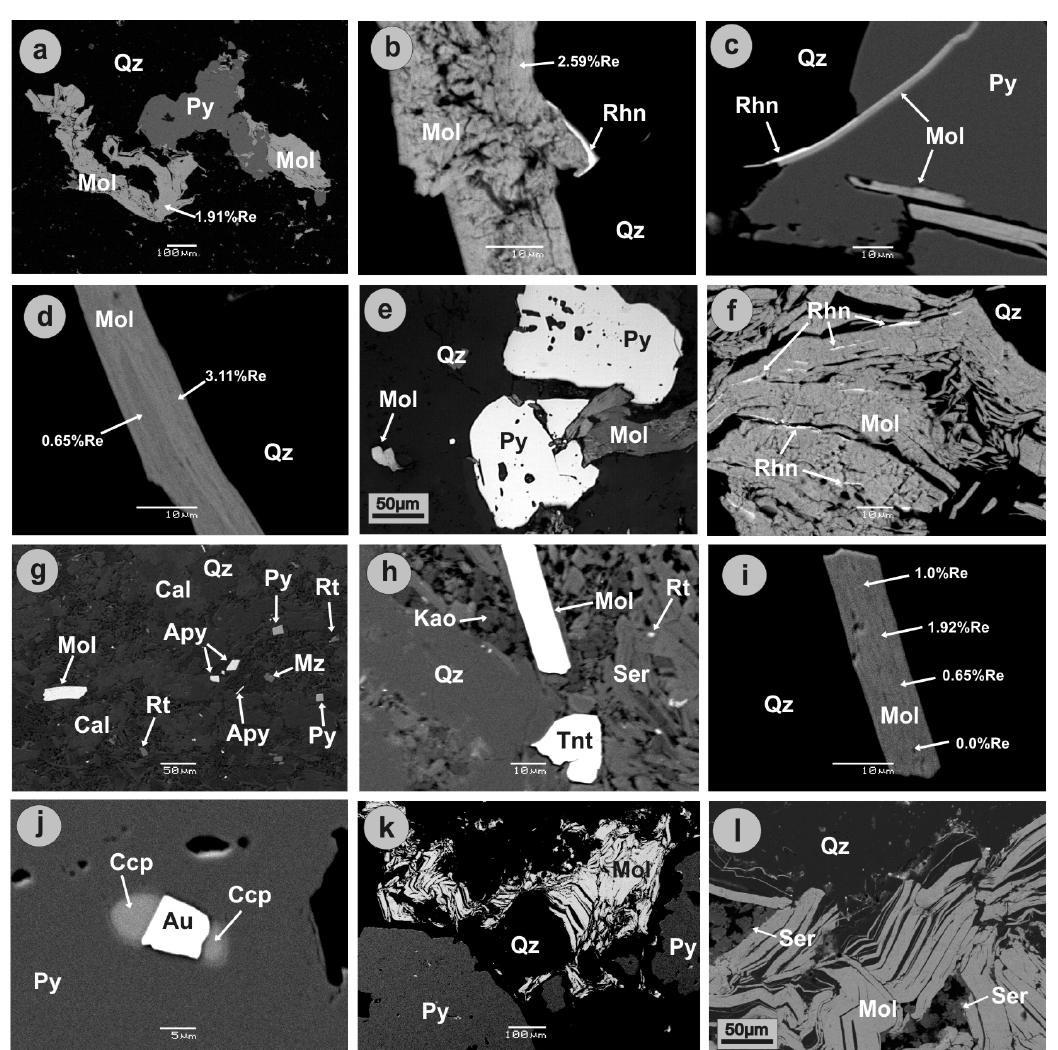
Figure 5. Photomicrographs of molybdenite and rheniite-bearing assemblages in quartz veins from the northeastern Greek prospects ( a ) Re-bearing molybdenite (Mol) with up to 1.9 wt % Re, associated with pyrite (Py) and included in quartz (Qz) (SEM-BSE image, Konos); ( b , c ) Re-bearing molybdenite (Mol) surrounded by rheniite (Rhn). Pyrite (Py) and quartz (Qz) are also present (SEM-BSE images, Konos); ( d ) Zoned molybdenite crystal (Mol) with Re-content ranging from 0.65 wt % Re in the core to 3.11 wt % towards the margin of the grain (SEM-BSE image, Konos); ( e ) Re-rich molybdenite (Mol) with pyrite (Py) and included in quartz (Qz) (reflected light, Pagoni Rachi); ( f ) Re-bearing molybdenite (Mol) interfingered and surrounded by rheniite (Rhn) (SEM-BSE image, Pagoni Rachi); ( g ) Molybdenite (Mol), pyrite (Py), arsenopyrite (Apy), accompanied by rutile (Rt), monazite (Mz), calcite (Cal), and quartz (Qz) (SEM-BSE image, Myli); ( h ) Molybdenite (Mol) and tennantite (Tnt) within quartz (Qz), sericite (Ser), kaolinite (Kao). Rutile (Rt) is also present (SEM-BSE image, Myli); ( i ) The Re content of the molybdenite crystal shown in Figure 5h (SEM-BSE image, Myli); ( j ) Native gold (Au) and chalcopyrite (Cpy) included in pyrite (Py) (SEM-BSE image, Myli); ( k , l ) Molybdenite (Mol) surrounding pyrite (Py) and associated quartz (Qz), sericite (Ser) (SEM-BSE image,